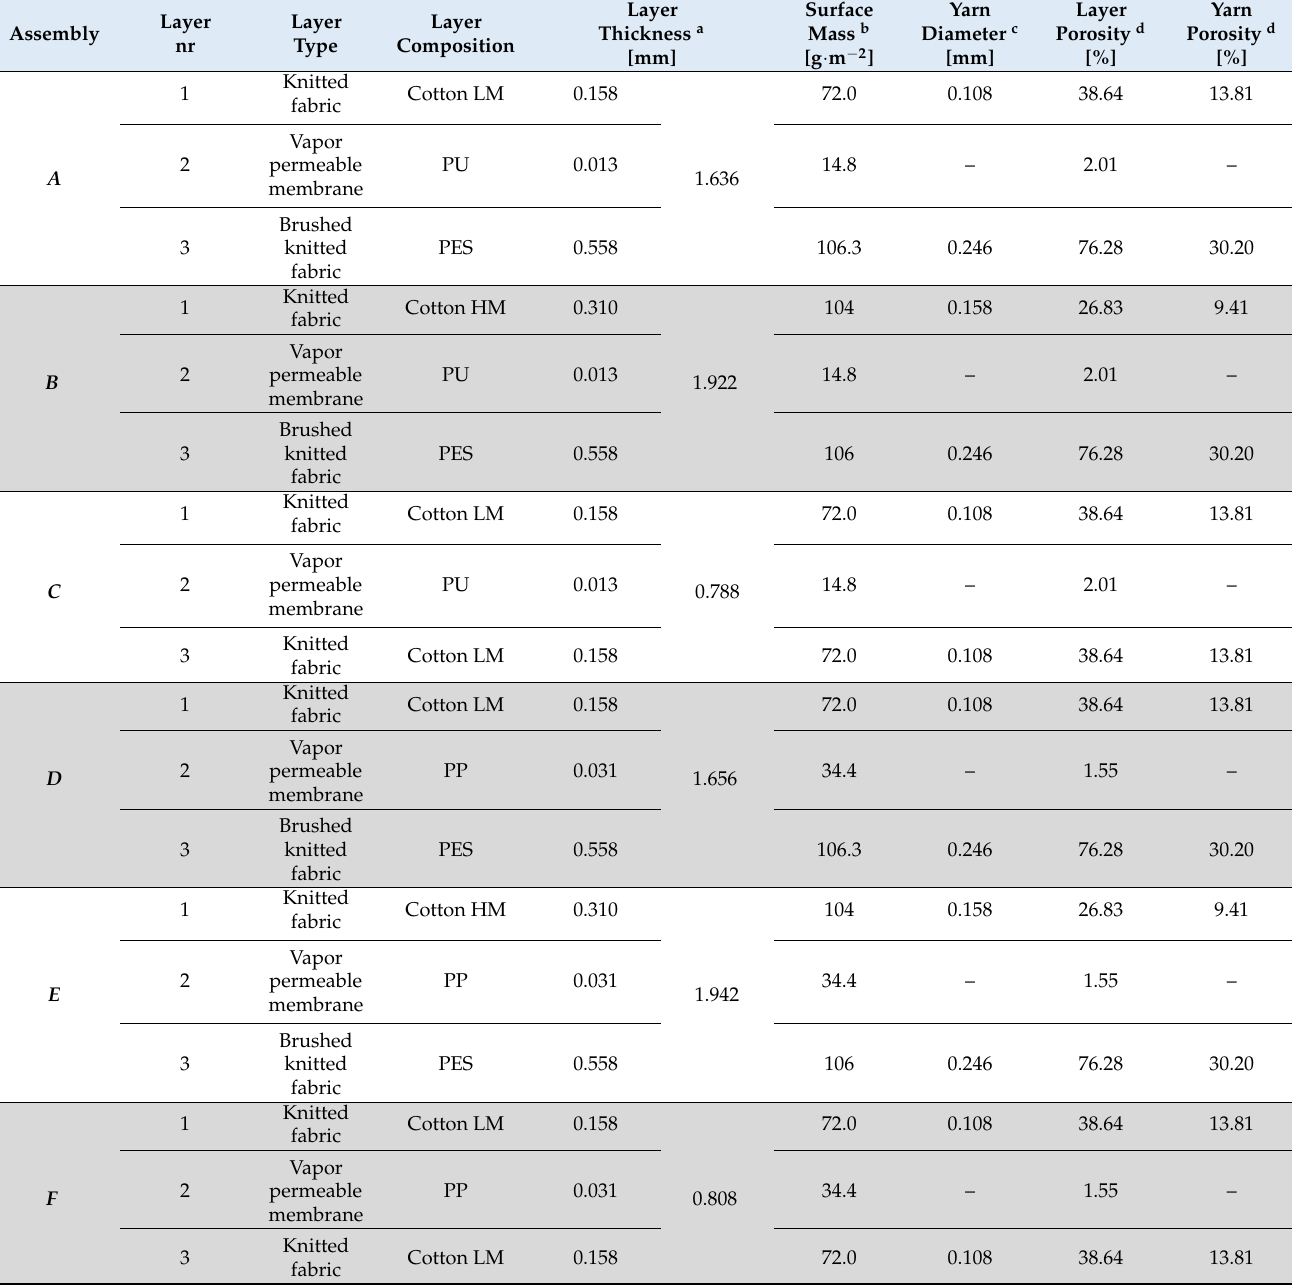
Table 1. Characteristics of six tested